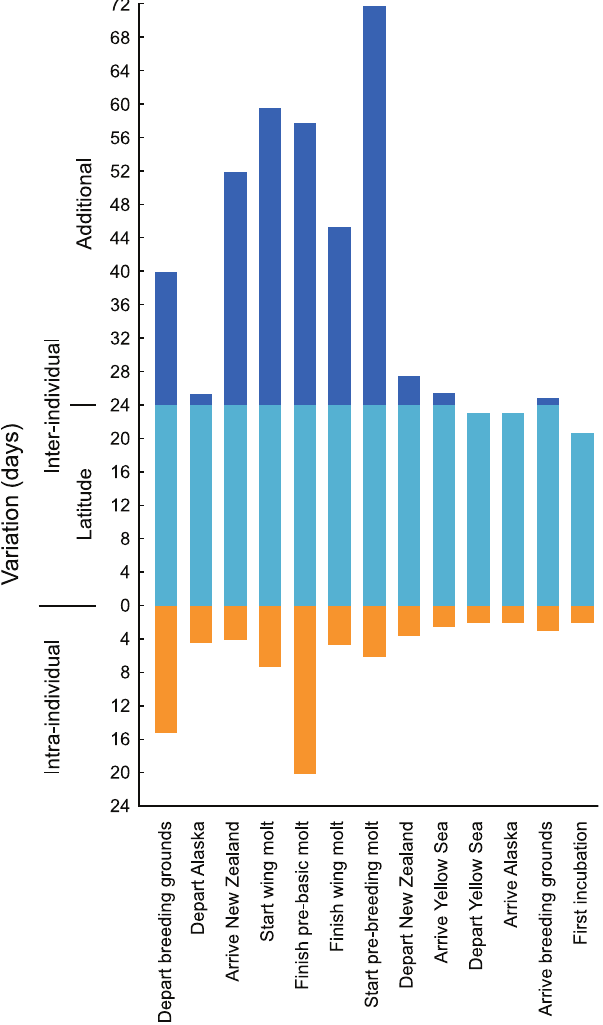
Figure 4. Components of population variation in timing of annual cycle events of bar-tailed godwits. For each stage, bar indicates total span of population variation (see Figure 2A). ‘Intra- individual’ (orange) indicates median individual difference between years (2-year geolocators only; see Figure 2B). ‘Latitude’ (light blue) represents expected inter-individual variation related to breeding latitude (24 d). ‘Additional’ (dark blue) indicates remaining inter- individual variation after subtracting latitude